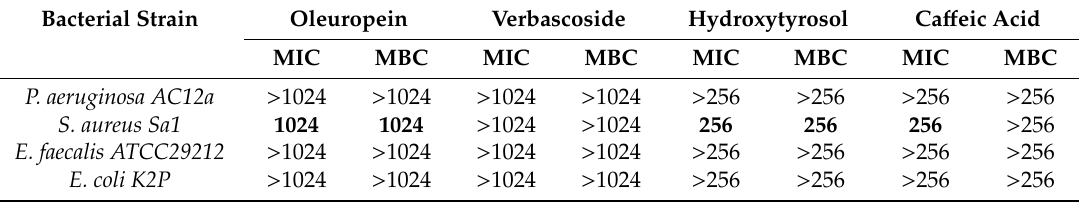
Table 6. In vitro activity of oleuropein, verbascoside and derivatives (hydroxytyrosol and ca ff eic acid, respectively) against bacterial strains representative for Gram-positive and Gram-negative pathogens. The minimum inhibitory concentration (MIC) and minimum bactericidal concentration (MBC) values of each compound were determined by the broth microdilution method and expressed as µ g /